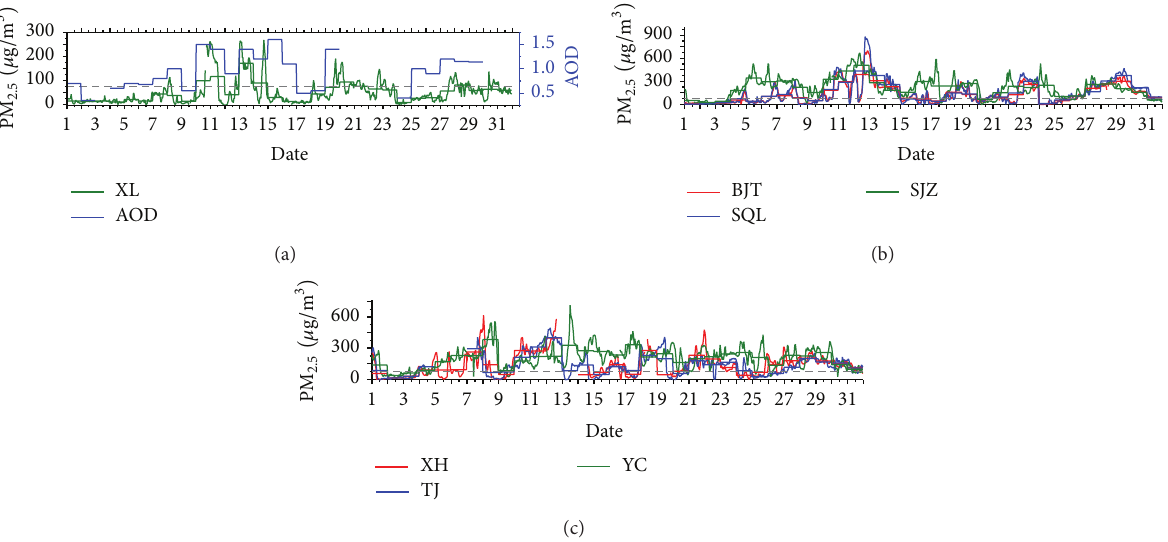
Figure 2: Variation of hourly average (sawtooth lines) and daily average (step lines) concentrations of PM 2.5 in different sites and regional average AOD in January 2013 over the BTH region. Dashed lines show the Grade II National Ambient Air Quality